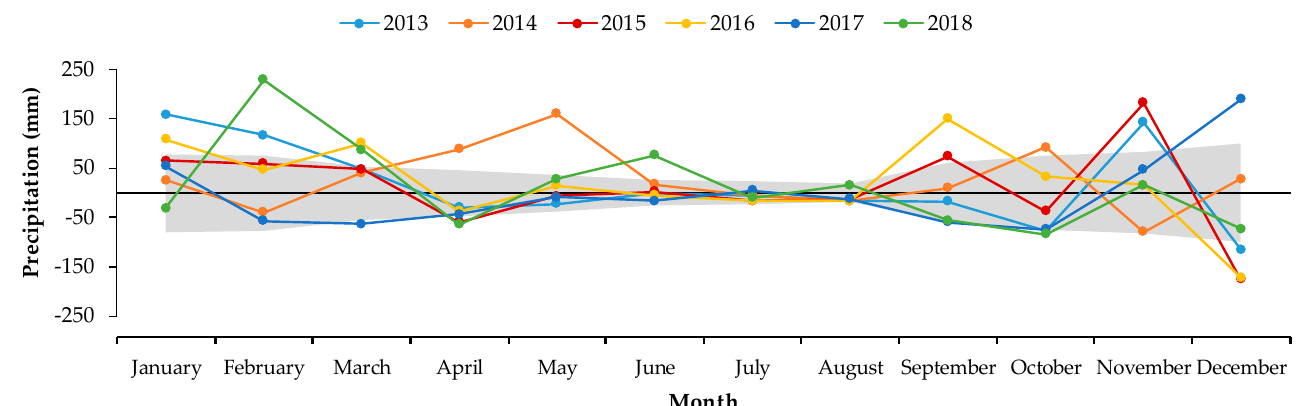
Figure 5. Deviations of total monthly precipitation (mm) from the monthly means of the climatic period 1973–2020. (Shaded areas depict the ± standard deviation (SD) of the same period (confidence interval ±95%)).